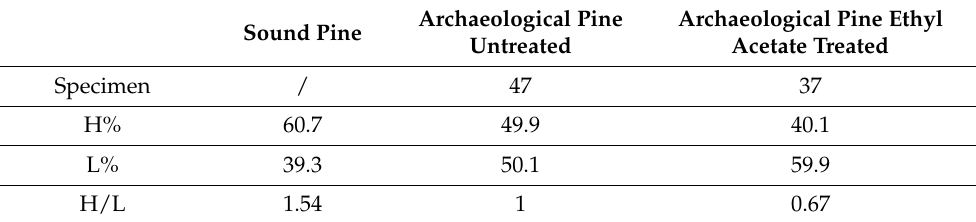
Table 4. Percentage composition of pine reference woods determined by Py-GC/MS, collected from external and internal parts of the cubes. H = holocellulose, L = lignin, H/L = ratio of holocellulose over lignin. Archaeological Pine Archaeological Pine Ethyl Sound Pine Untreated Acetate Treated Specimen / 47 37 H%